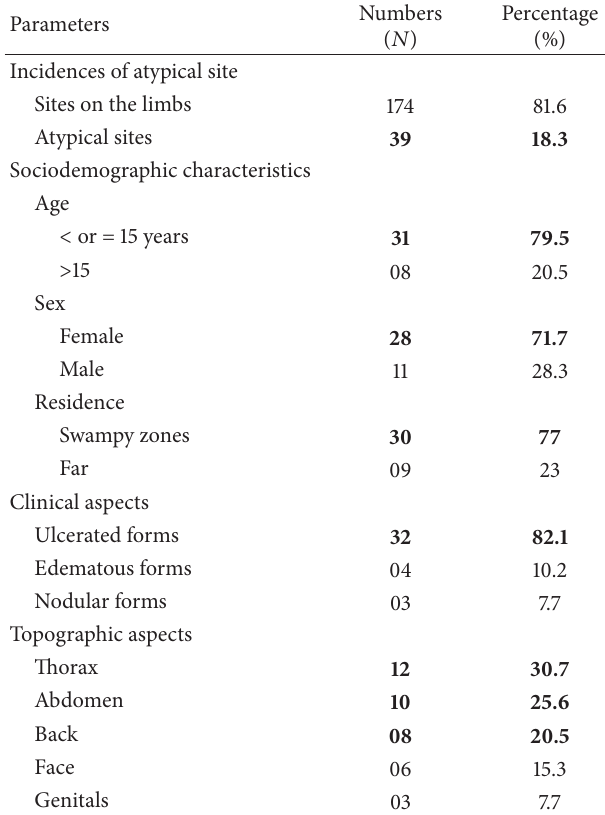
Table 1: Epidemiological and clinical characteristics of atypical